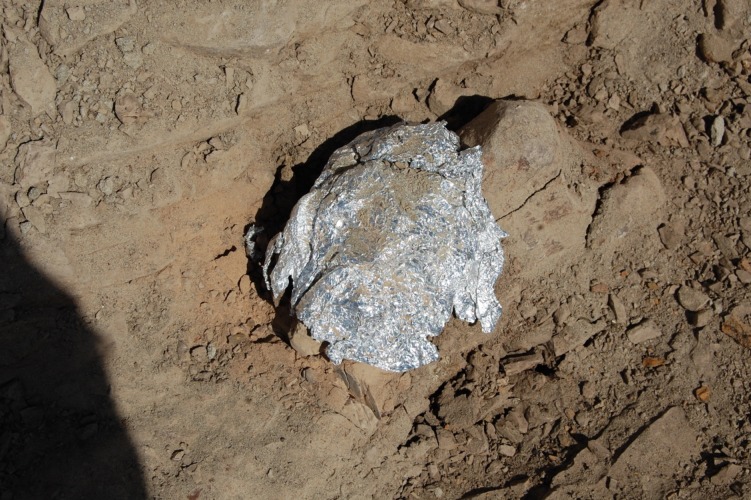
Foil placed on top of sediment and matrix-surrounded Centrosaurus tibia portion prior to flipping with an awl.Uncovered distal end of tibia is visible to the right of foil.